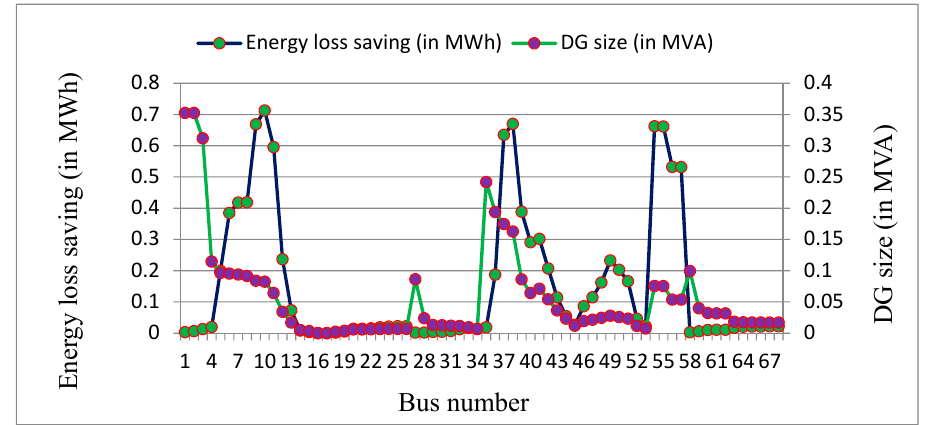
Figure 9. Loss saving of active energy component with corresponding sizes of DGs (in MVA) at different nodes for the second iteration when DGs are placed at nodes 3 and 6 for IEEE 69-bus system.